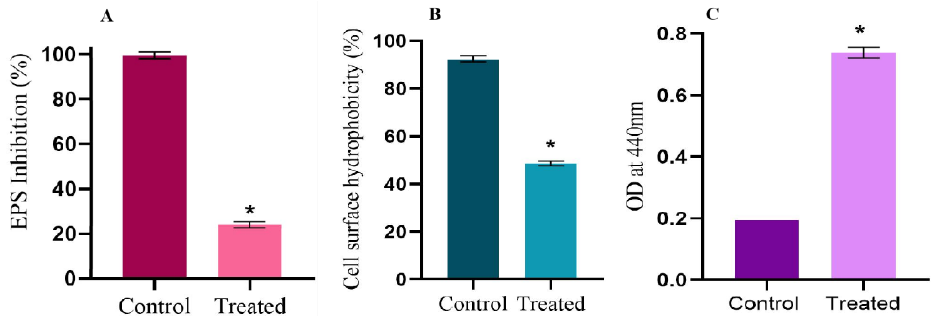
Figure 5. Effect of Linalool on EPS production, cell surface hydrophobicity, and extracellular protease production. ( A ) Percentage inhibition of EPS grown in the presence of Linalool (0.004%). ( B ) Graph showing the cell surface hydrophobicity (CSH) of Streptococcus pyogenes SF370 in the absence and presence of Linalool (0.004%). ( C ) The graph displays extracellular cysteine protease production by S. pyogenes in the absence and presence of Linalool at the MBIC concentration. Data are represented as mean ± S.D. Asterisks denote statistical significance ( p < 0.05).